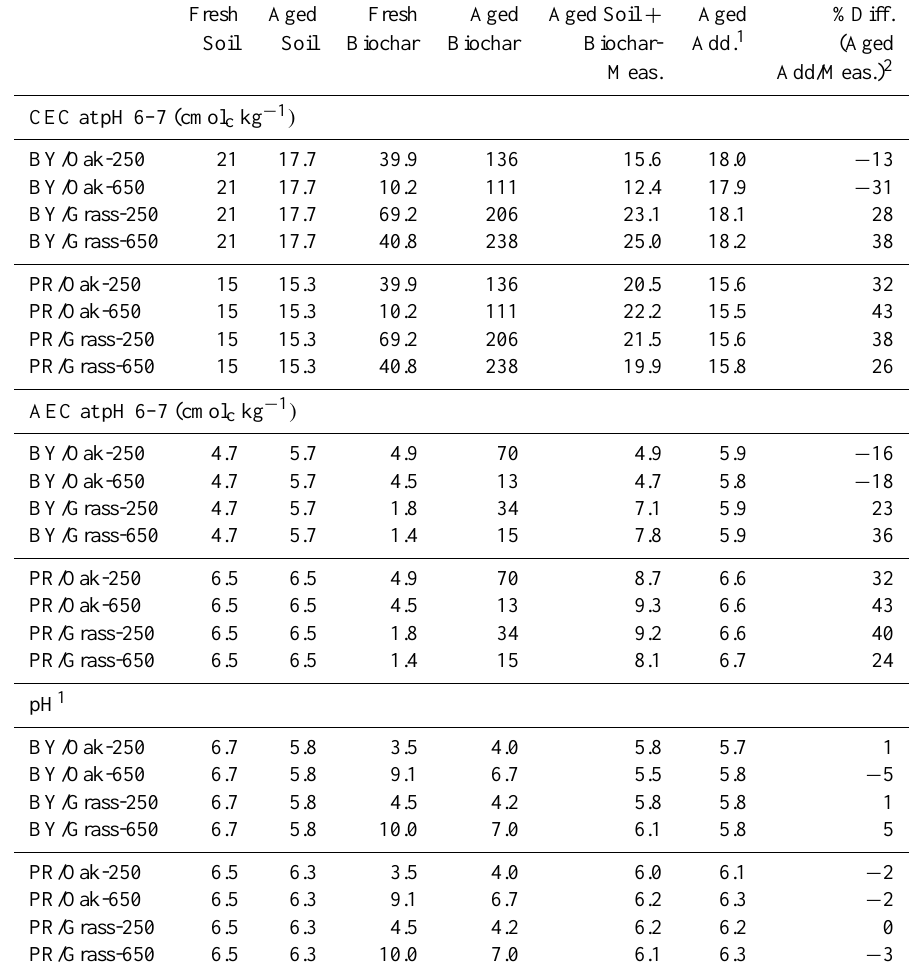
Table 2. Average cation and anion exchange capacity and pH of fresh and field-aged soils, biochars and soil/biochar mixtures (Meas.) and those predicted by the arithmetic weighted combination of each biochar and soil (Add.). Fresh Aged Fresh Aged Aged Soil + Aged %Diff. Soil Soil Biochar Biochar Biochar- Add. 1